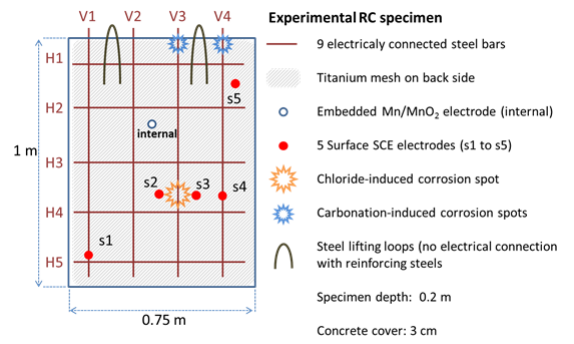
Figure 1. Reinforced concrete wall monitored by a six ‐ channels potentiostat ‐ galvanostat.